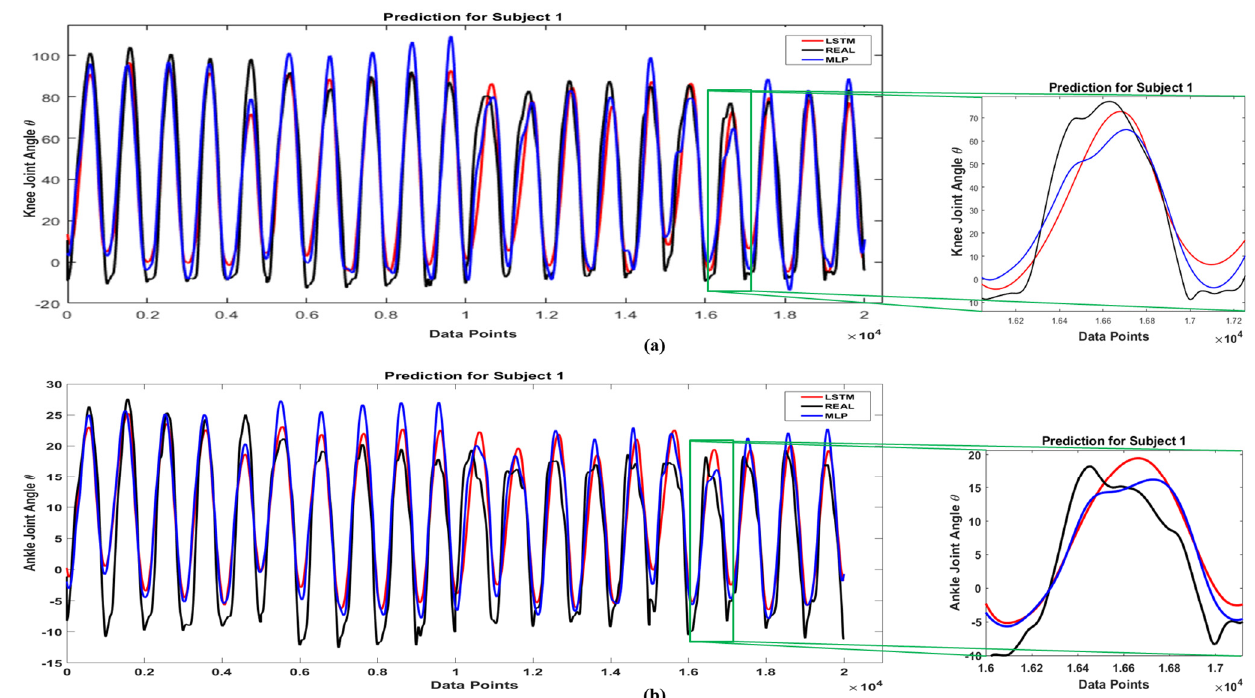
Sensors 2021 , 21 , x FOR PEER REVIEW 12 of 16